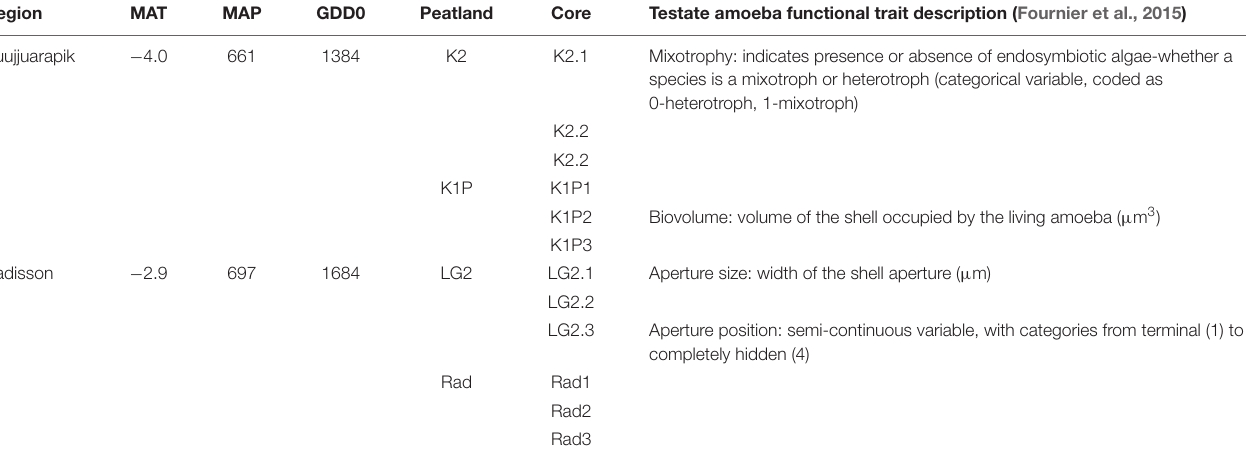
TABLE 1 | Site information and analyzed testate amoeba functional trait description. Region MAT MAP GDD0 Peatland Core Testate amoeba functional trait description (Fournier et al., 2015)